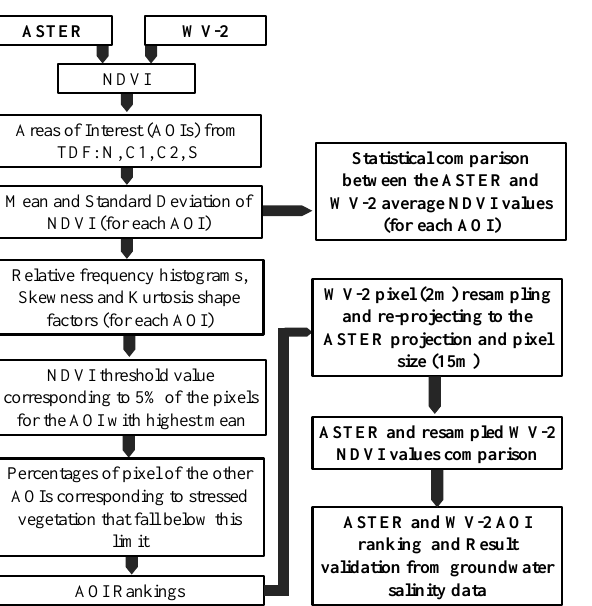
Figure 2. Flow chart of the whole procedure used to compare ASTER and WV-2